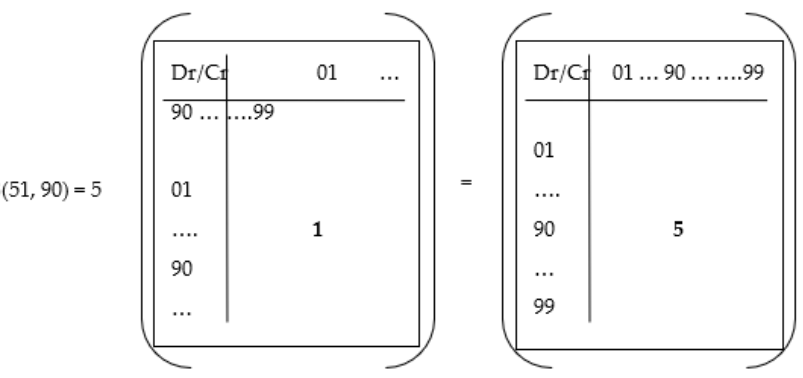
Figure 6. A matrix of correspondence B(51, 90) = 5 lines of costs by stages of innovation project.